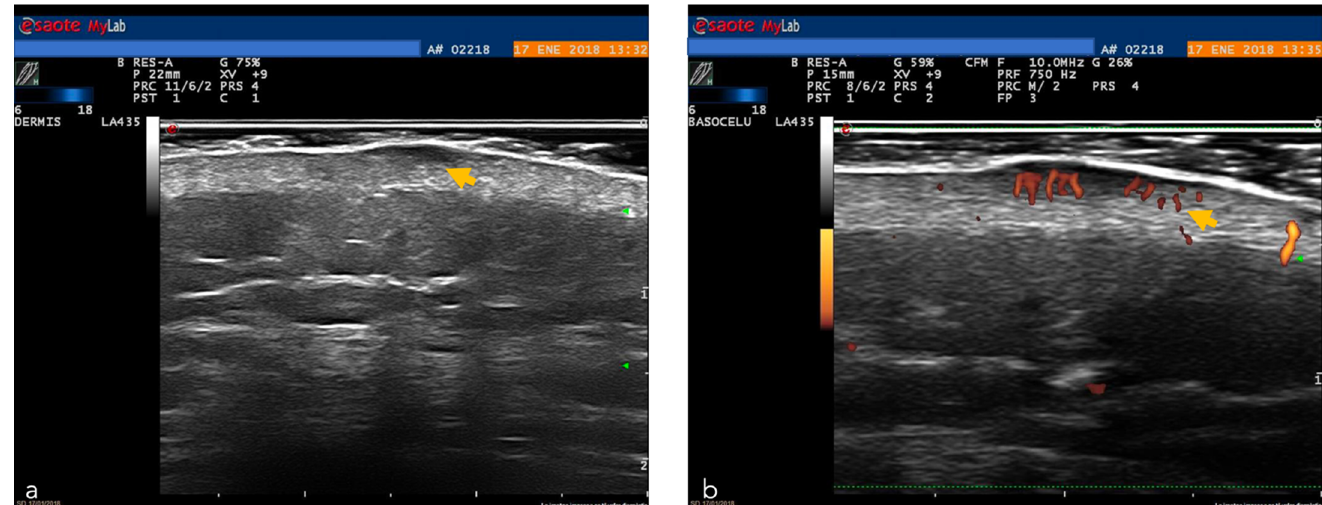
Figure 12. High-frequency ultrasound. A probe of 18 MHz: ( a ) Superficial basal cell carcinoma (yellow arrow); ( b ) Doppler image (yellow arrow) around the basal cell carcinoma. Image courtesy of Dr. Priscila Giavedoni.